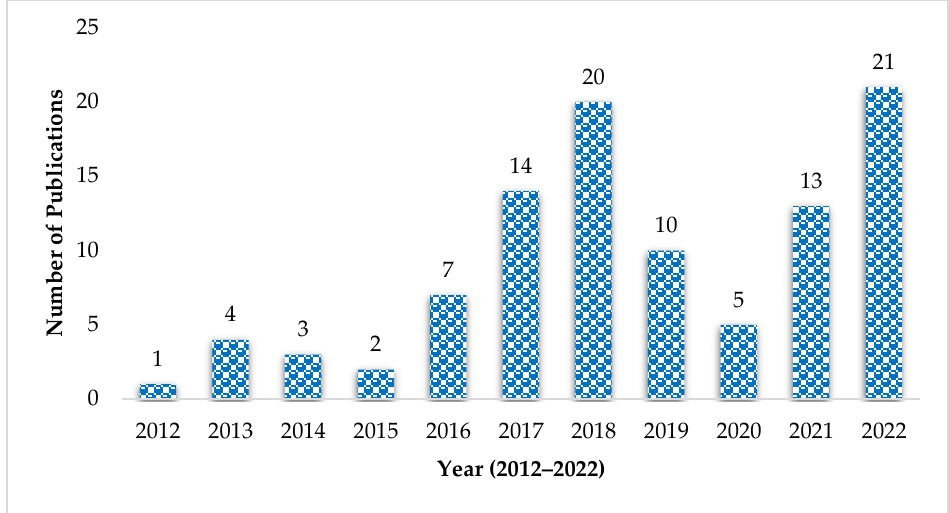
Figure 3. Publications over time.